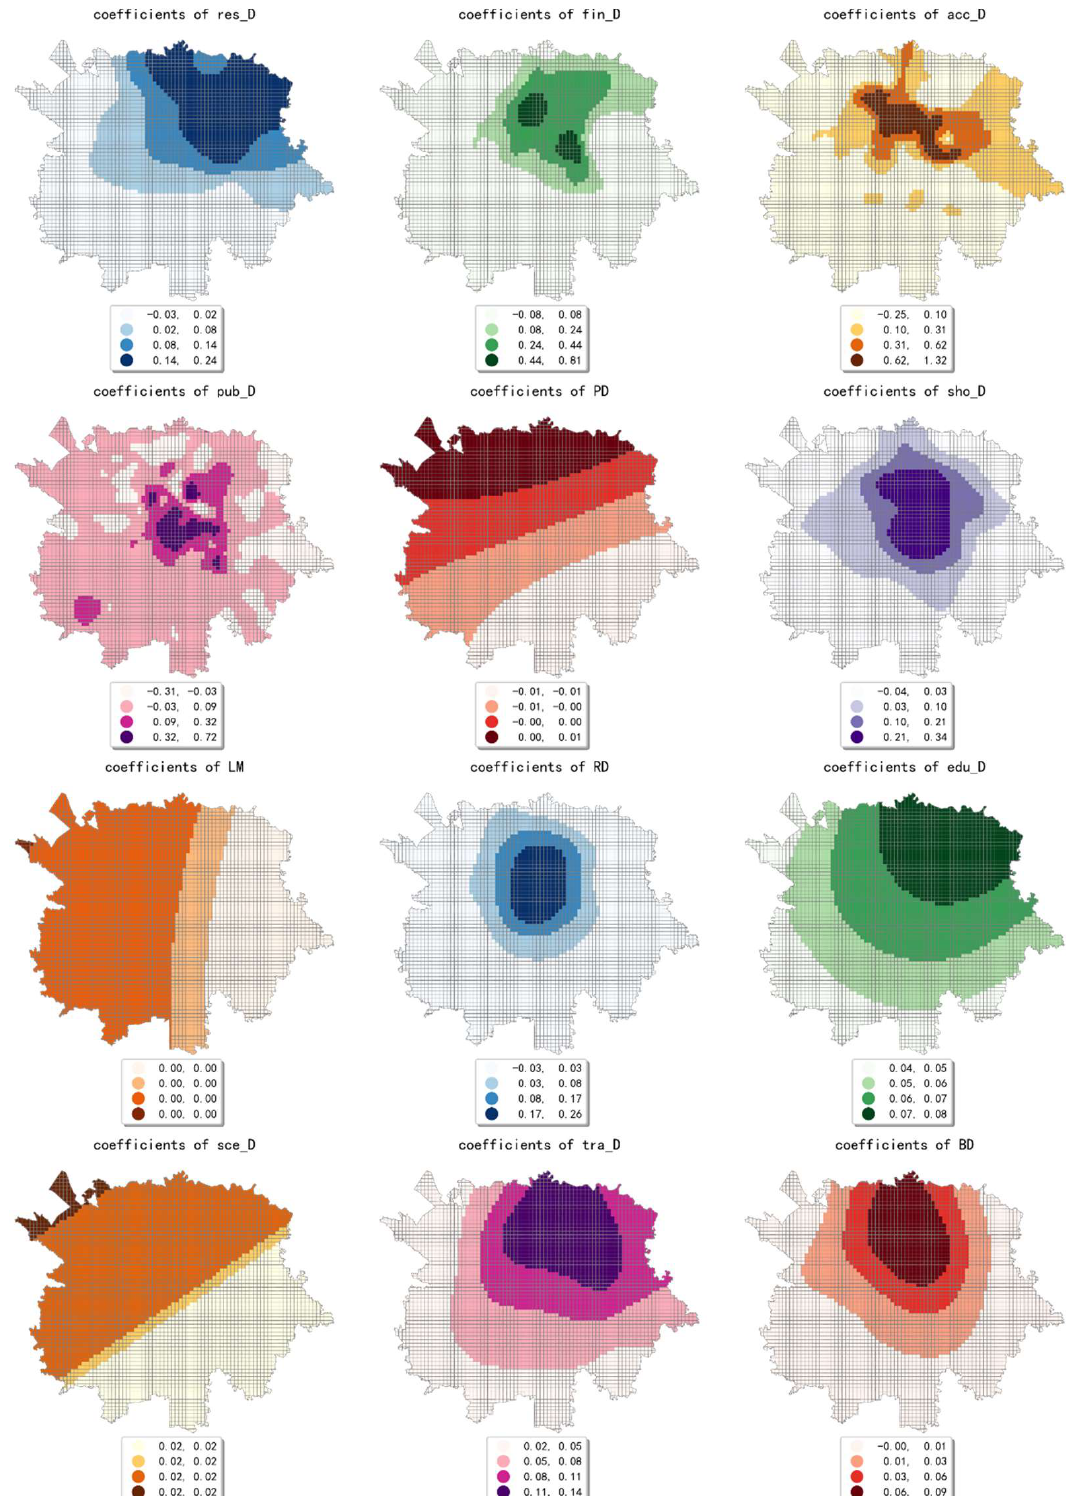
Figure 2. The estimated coefficient maps in the grid with 500 m.